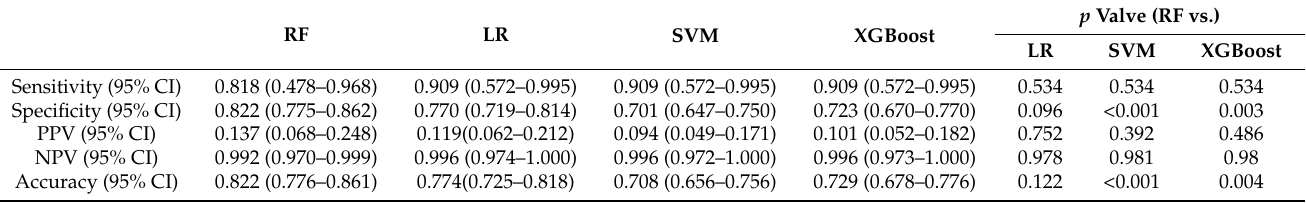
Table 3. Performance of machine learning models in the testing